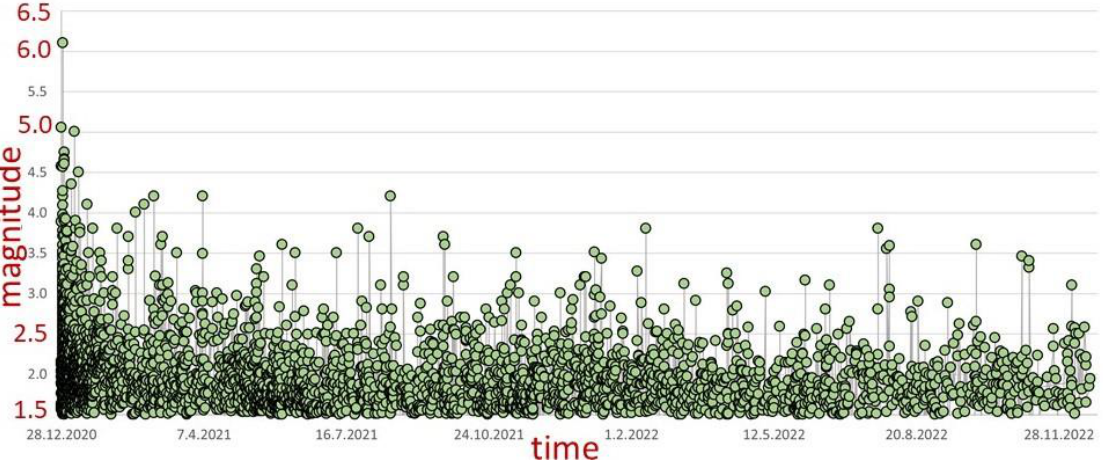
Figure 3. Magnitudes of the earthquakes from 28 December 2020 to 28 December 2022 [6]. The most affected areas were the villages and cities in the valley of the meandering rivers, Kupa and Sava, and their tributaries, with mostly soft layers of sands, silts, and clays, and a high ground water table [8,9].